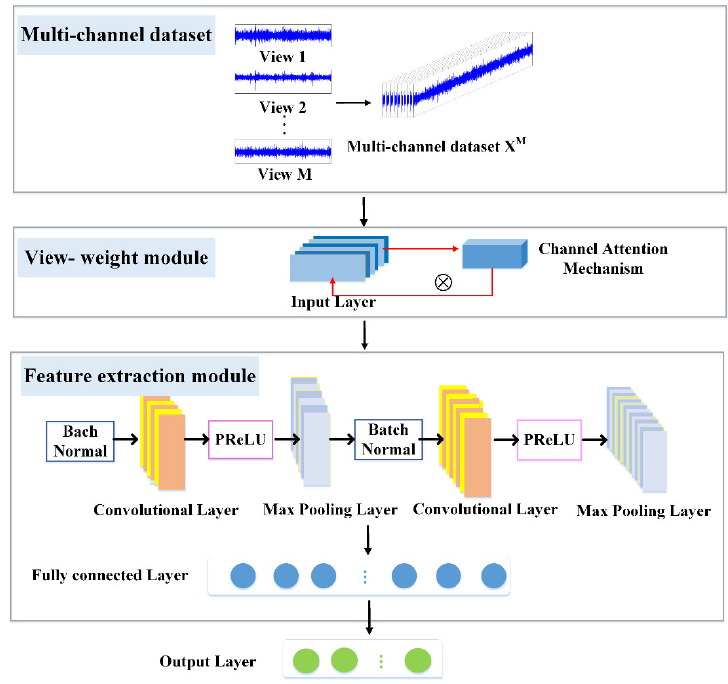
Figure 1. Framework of the CAM_MCFCNN model.